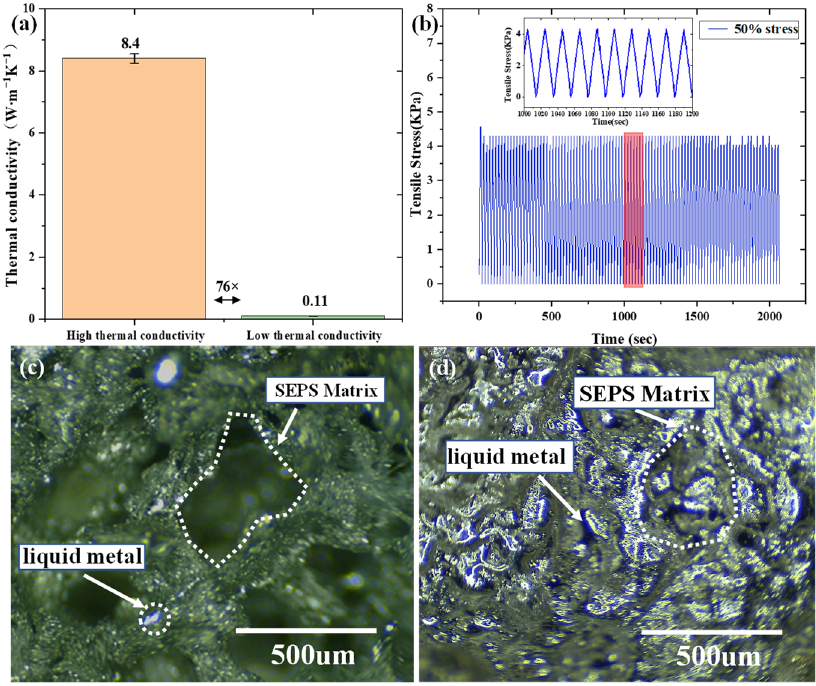
Figure 3. ( a ) Comparison of the thermal conductivity of B-LM-ECF at the high and low thermal conductivity. ( b ) Graph of 100 cyclic stretching experiments of B-LM-ECF. Optical micrograph of the section of B-LM-ECF with ( c ) low thermal conductivity and ( d ) high thermal conductivity.